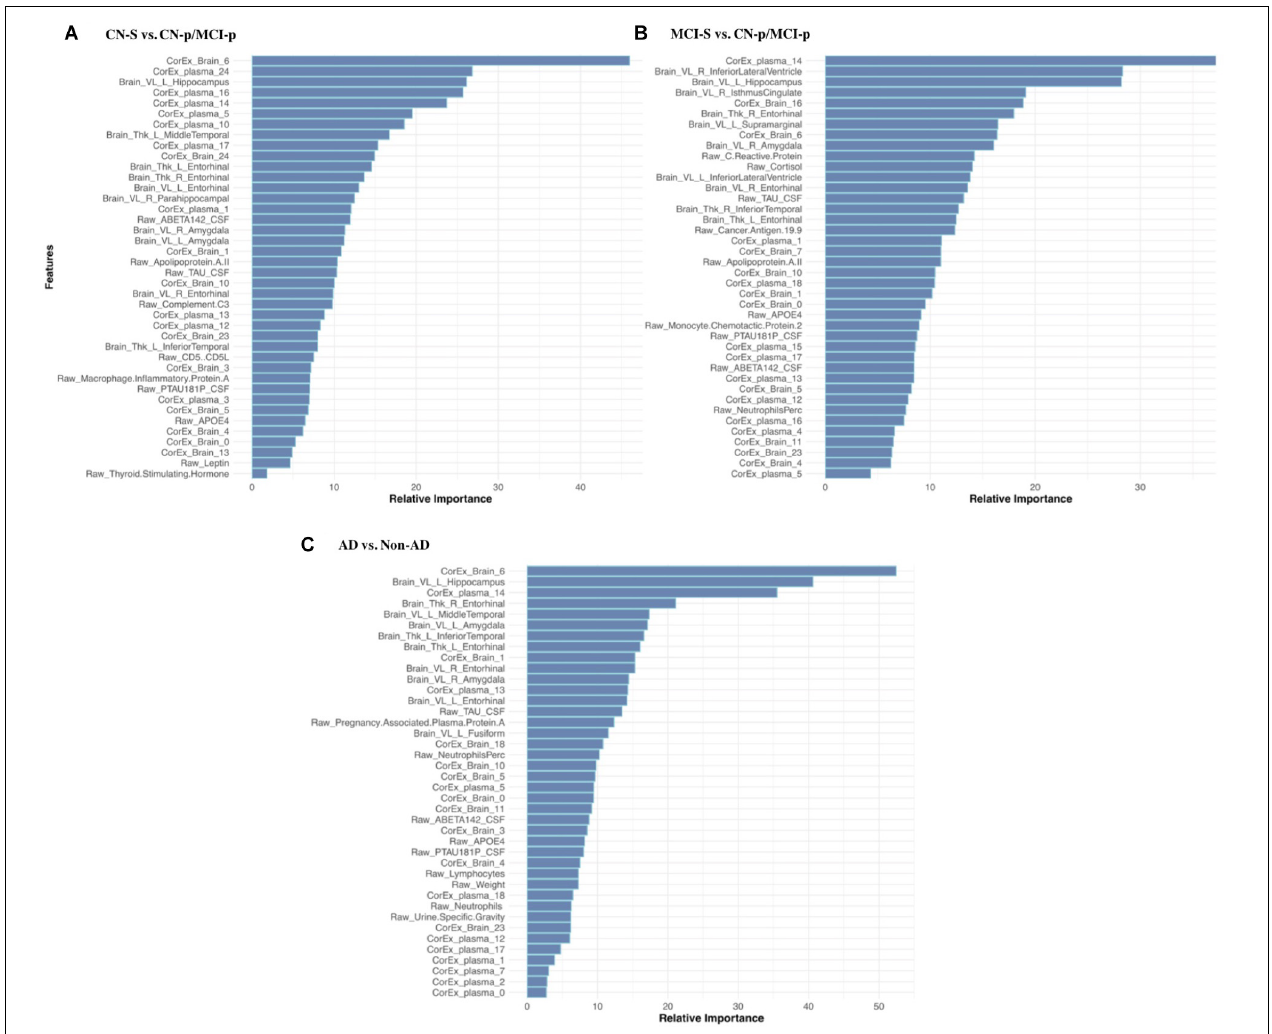
FIGURE 6 | Feature selection results for longitudinal prediction of AD. Using our ensemble feature selection technique outlined in the Methods section, we identified the top 10 features within each feature type (CorEx plasma, CorEx brain, plasma, brain) across each of our three diagnostic groups used for prediction: (A) CN-s